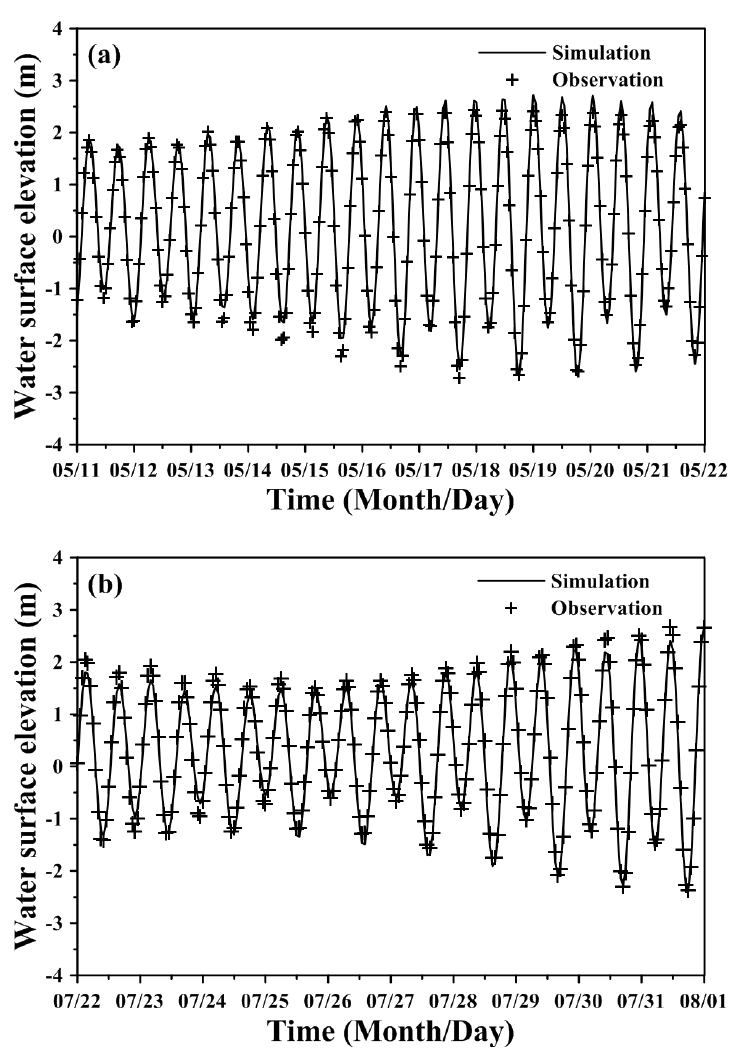
Figure 6. Comparison of model results and observed water surface elevation during the periods of ( a ) 11–21 May 2011 and ( b ) 22–31 July 2011 at the Taichung Harbor